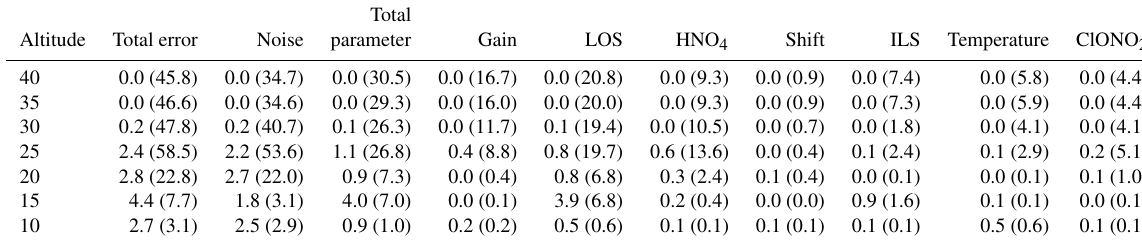
Table A3. Error estimates for a polar winter profile during the FR period. Errors are given in pptv (relative errors in %).